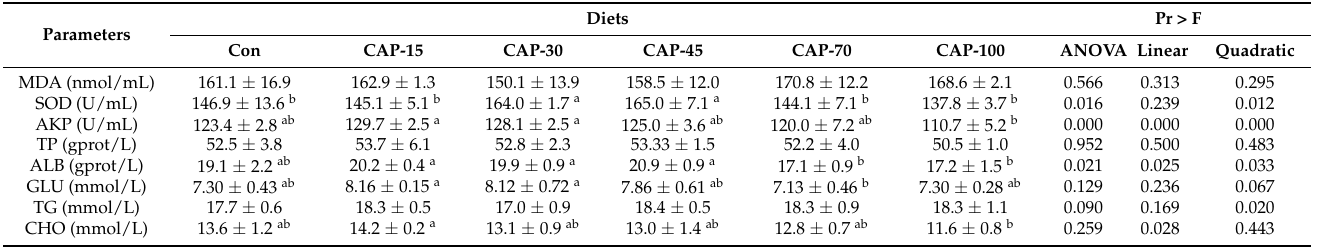
Table 6. Effects of dietary Clostridium autoethanogenum protein on serum biochemical indices of largemouth